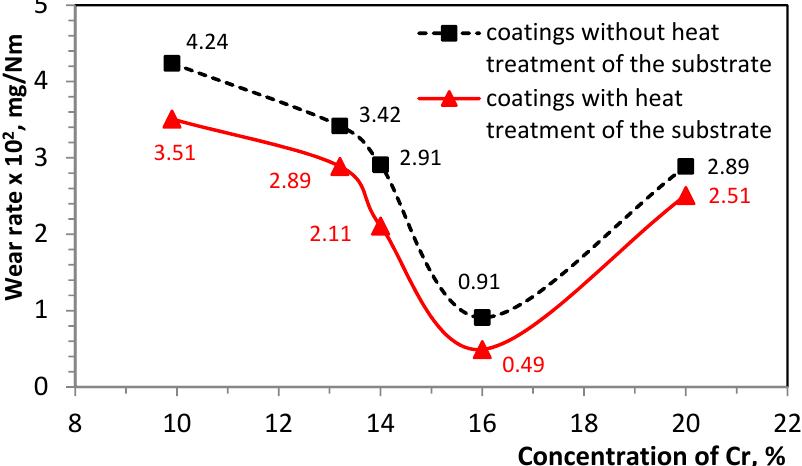
Figure 8. Dependence of wear rate on the concentration of chromium in the tested HVOF-coatings.